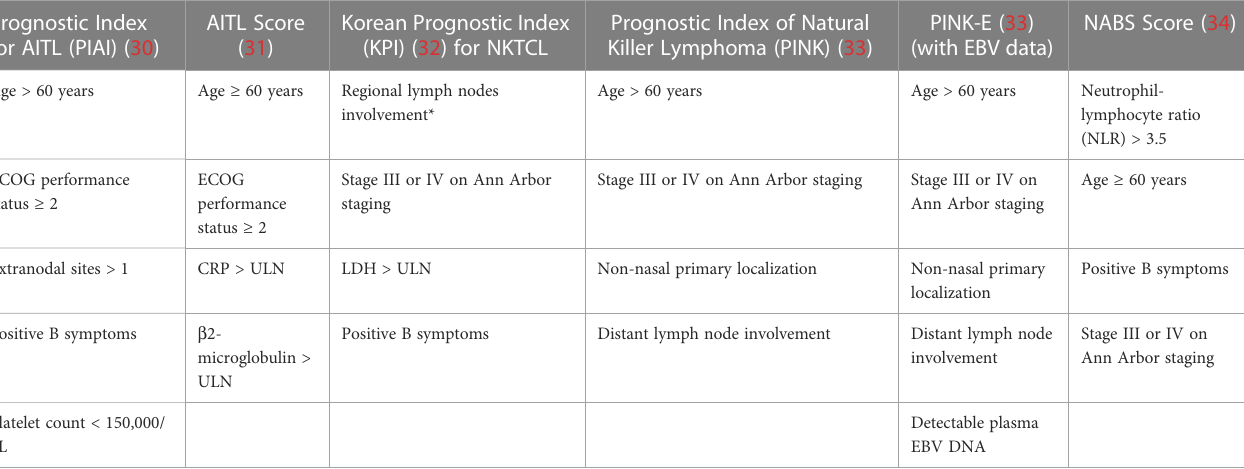
TABLE 2 Criteria for specialized prognostic